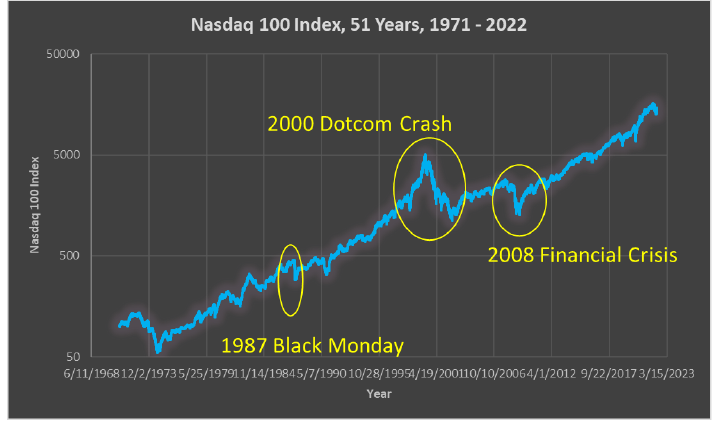
Figure 1. A remarkable century of markets and growth, even through the Depression and World Wars: ( top ) 105 years of the Dow; ( middle ) 95 years of the S&P500; ( bottom ) 51 years of the Nasdaq index; data from (Macrotrends